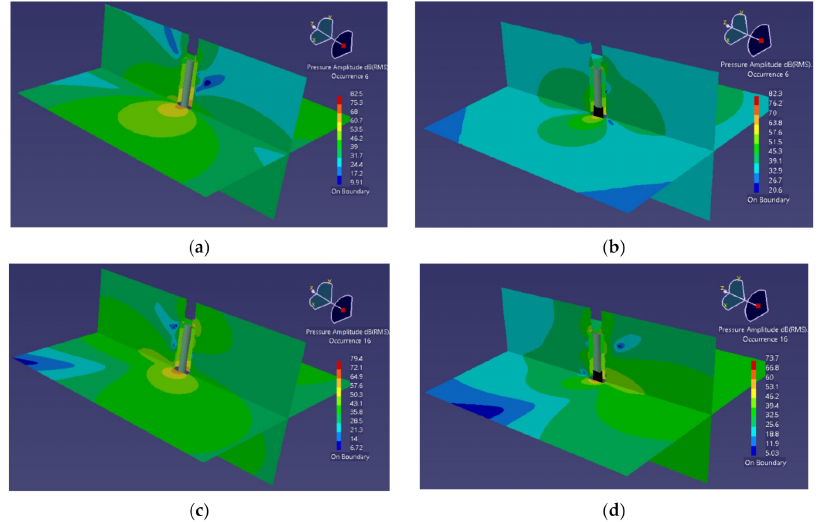
Figure 11. Radiation maps of noise at different frequencies when flow speed is 60 m/s: ( a ) f = 40 Hz, without rings; ( b ) f = 40 Hz, with rings; ( c ) f = 80 Hz, without rings; ( d ) f = 80 Hz, with